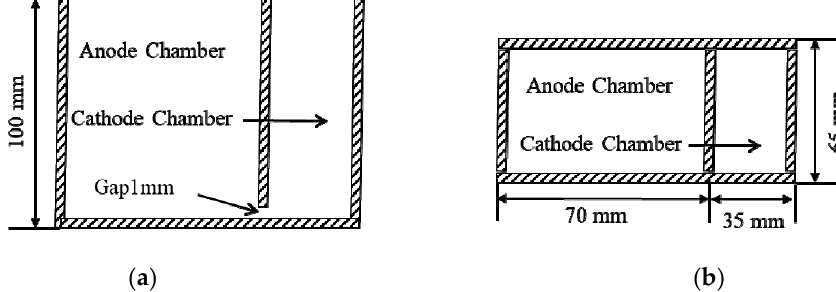
Figure 2. Double ‐ chamber quartz crucible showing the anode and cathode chamber. ( a ) front view; ( b ) top view.